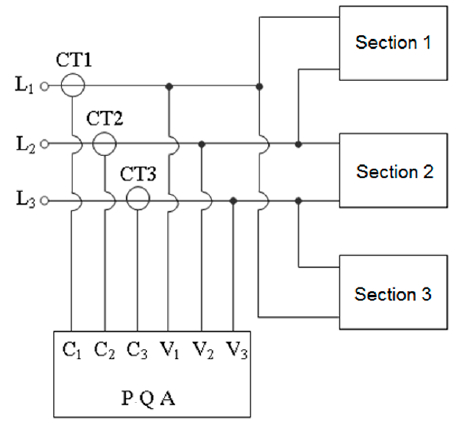
Figure 17. Connection of ESPs sections to the low ‐ voltage network [28].